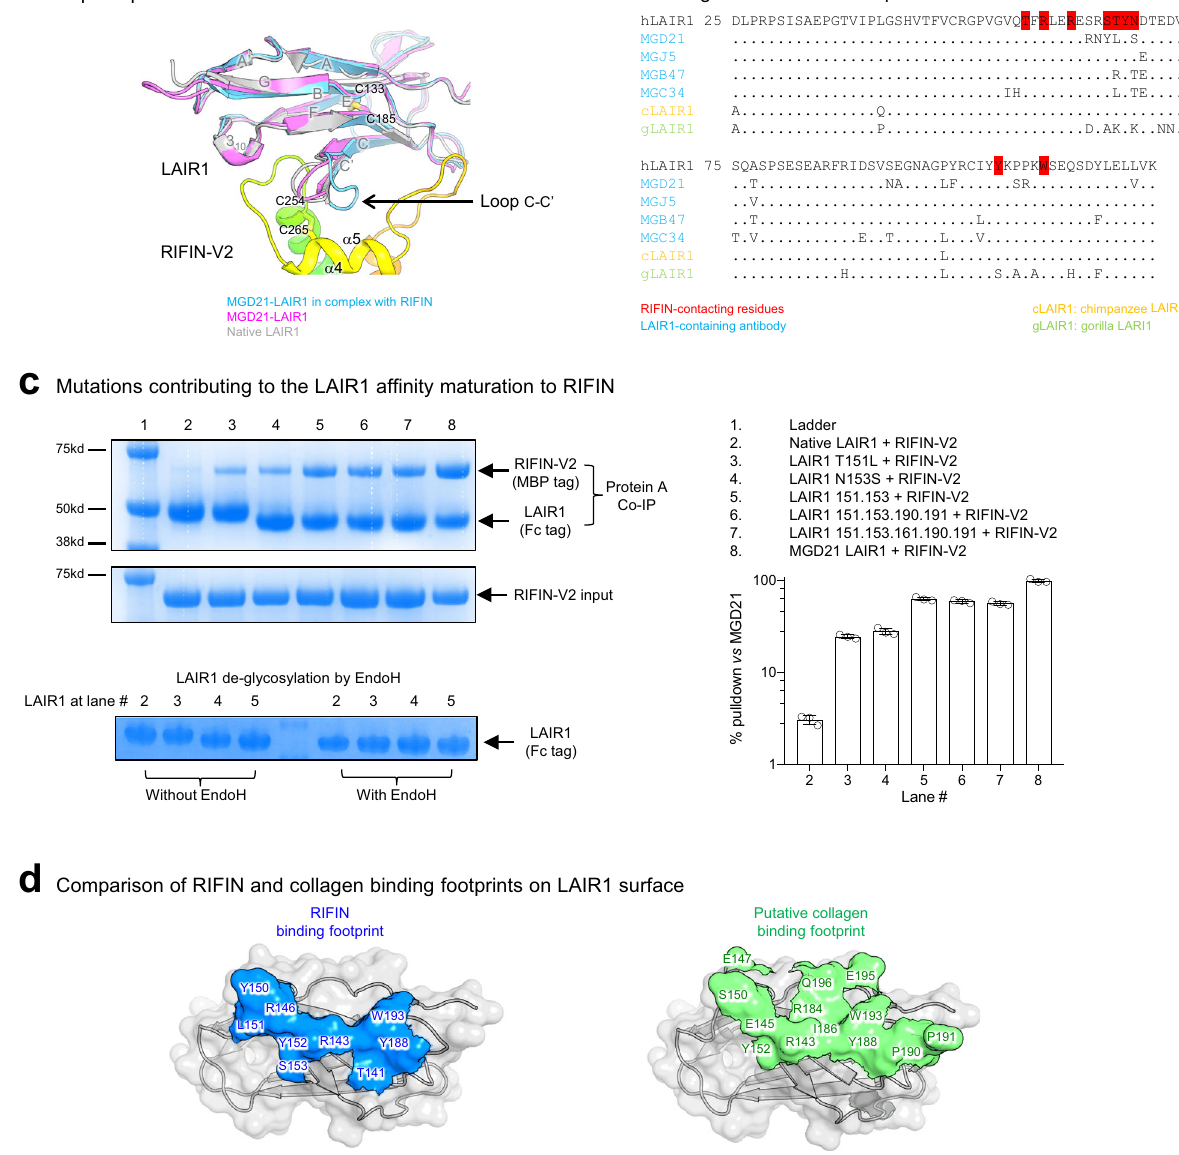
Fig. 2 Structural and sequence analysis of various LAIR1 constructs identi fi es RIFIN-binding essential. a Conformational change on LAIR1 c-c ’ loop to enable RIFIN binding. b Alignment of LAIR1 sequences. (MGD21, hLAIR1: native human LAIR1, MGJ5, MGB47, MGC34, gLAIR1: gorilla LAIR1). c Accumulation of critical mutations allows af fi nity maturation of LAIR1 to RIFIN (upper left panel: SDS-PAGE image; lower left: LAIR1 de-glycosylation by EndoH; upper right panel: SDS-PAGE sample loading list; lower right panel: Quanti fi cation of left panel by bar graph. Data are presented as mean values ± SD). n = 3 independent measurements. The SDS-PAGE runs were repeated at least twice. d RIFIN binding footprint overlapped that of collagen on LAIR1 surface. Note: LAIR1 residue numbering is based on MGD21 construct, which has 84 shift to that of native